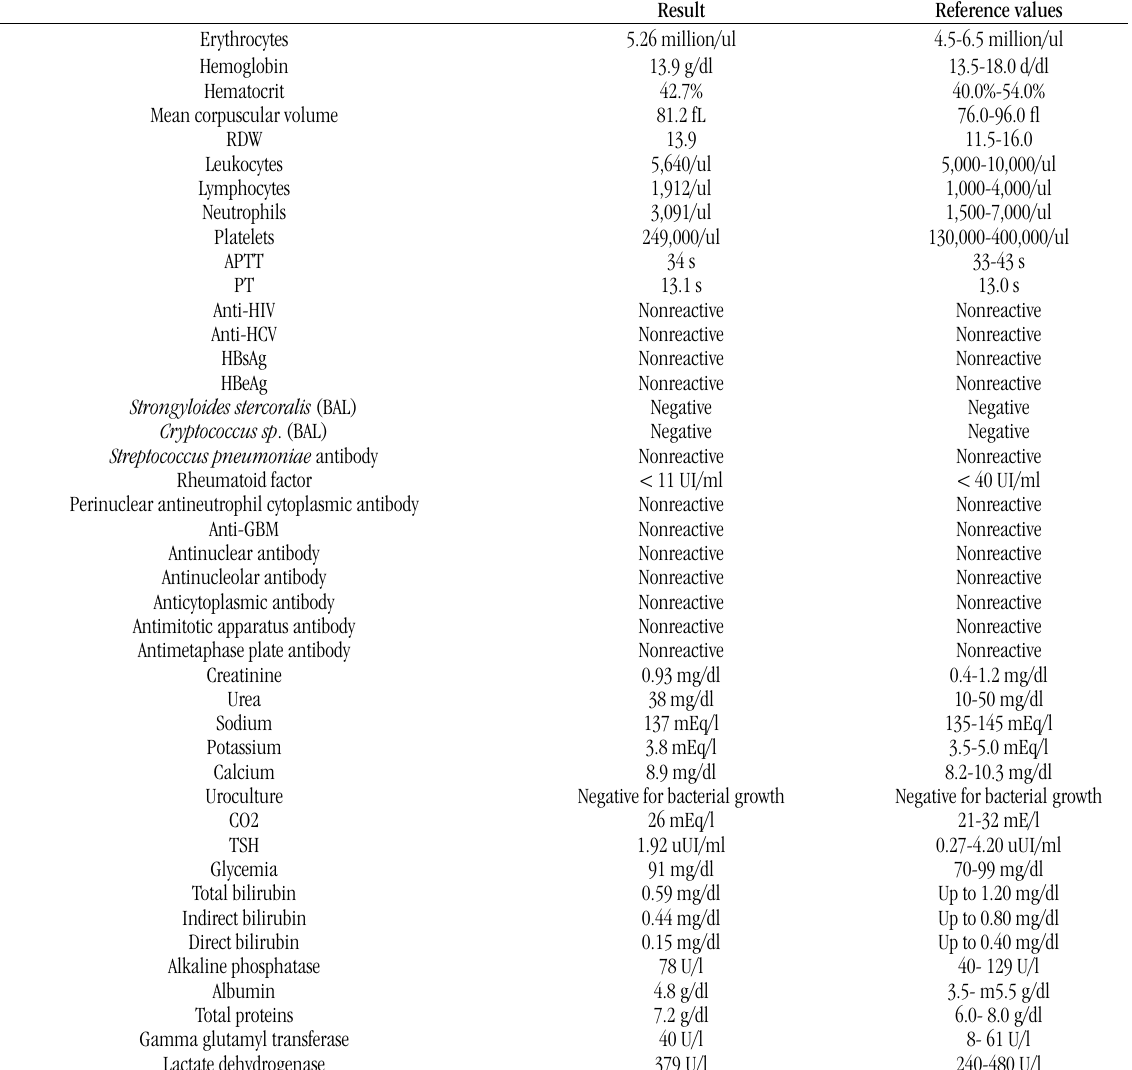
tABLE 1 – IPH: clinical data